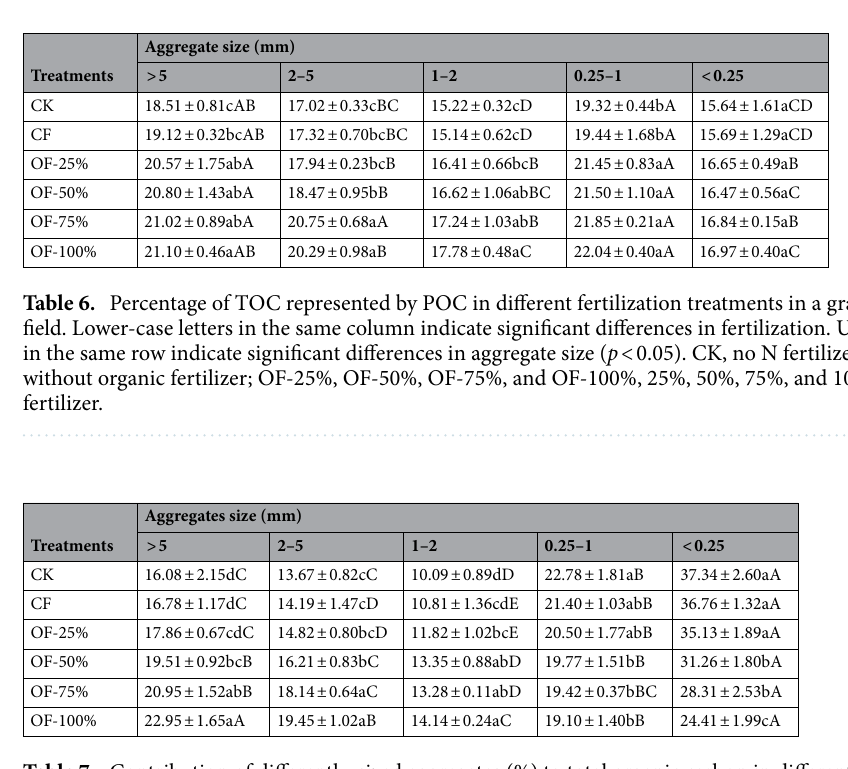
Table 7. Contribution of differently-sized aggregates (%) to total organic carbon in different fertilization treatments in a gravel-mulched field. Lower-case letters in the same column indicate significant differences in fertilization. Upper-case letters in the same row indicate significant differences in aggregate size ( p < 0.05). CK, no N fertilizer; CF, N fertilizer without organic fertilizer; OF-25%, OF-50%, OF-75%, and OF-100%, 25%, 50%, 75%, and 100% organic fertilizer.